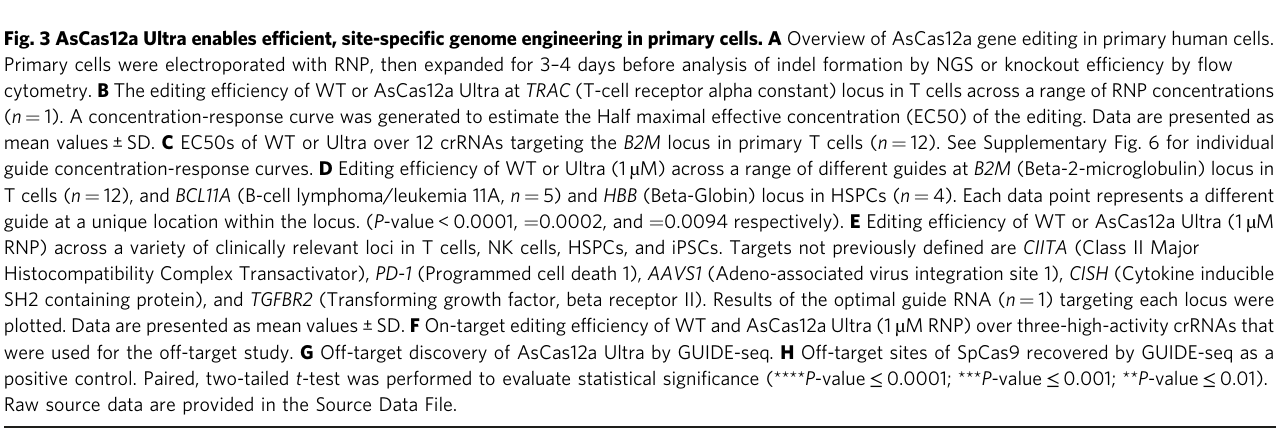
Fig. 3 AsCas12a Ultra enables ef fi cient, site-speci fi c genome engineering in primary cells. A Overview of AsCas12a gene editing in primary human cells. Primary cells were electroporated with RNP, then expanded for 3 – 4 days before analysis of indel formation by NGS or knockout ef fi ciency by fl ow cytometry. B The editing ef fi ciency of WT or AsCas12a Ultra at TRAC (T-cell receptor alpha constant) locus in T cells across a range of RNP concentrations ( n = 1). A concentration-response curve was generated to estimate the Half maximal effective concentration (EC50) of the editing. Data are presented as mean values ± SD. C EC50s of WT or Ultra over 12 crRNAs targeting the B2M locus in primary T cells ( n = 12). See Supplementary Fig. 6 for